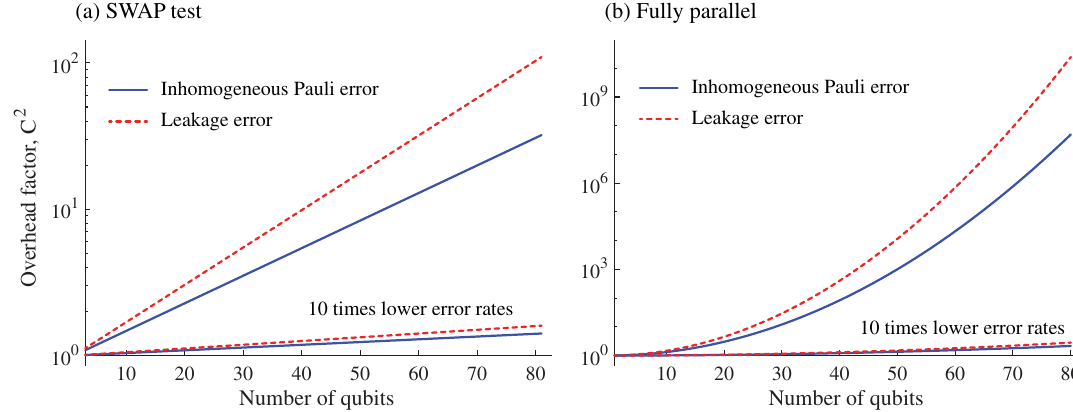
FIG. 7. The graphs show the cost of matching the performance of an ideal noiseless circuit with a noisy circuit, using the quasiprobability method. The vertical axis ( C 2 ) is a multiplicative factor indicating how many more repetitions of the circuit execution are requited. In each graph the upper pair of lines correspond to error rates achievable in ion trap experiments [28,29]; i.e., the error rate of two-qubit gate is 0.1% and error rates of single-qubit operations are 0.01%. The lower pair of lines indicate the result of reducing these error rates by a factor of 10. Panel (a) corresponds to the SWAP -test circuit. Panel (b) corresponds to a circuit where every qubit is actively gated in every time step, and the number of steps equals to the number of